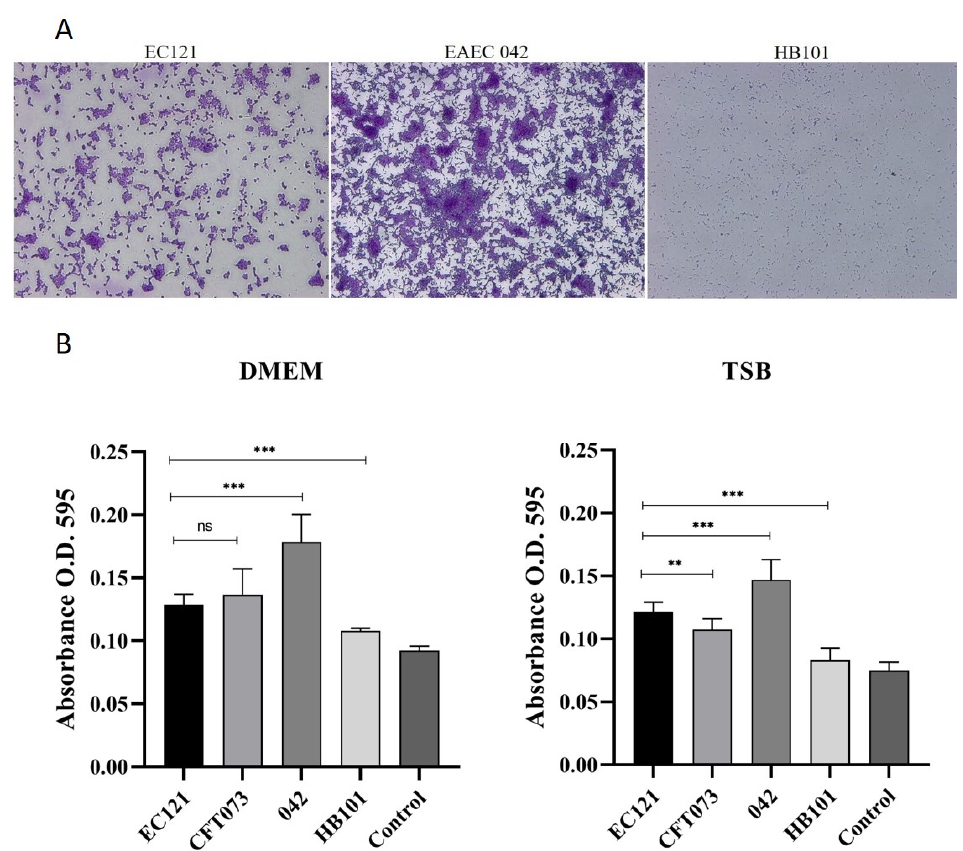
Figure 4. Biofilm formation on borosilicate glass and polystyrene abiotic surfaces. ( A ) Qualitative assay showing that EC121 strain adhered to glass coverslips after 24 h of incubation at 37 ◦ C, in DMEM. EAEC prototype strain 042 and E. coli HB101 were used as positive and negative controls, respectively. Bacteria were stained with crystal violet, observed by optical microscopy (OM) 400 × . ( B ) Quantitative biofilm assays were performed in Dulbecco (cid:48) s Modified Eagle (cid:48) s Medium (DMEM) and tryptic soy broth (TSB), at 37 ◦ C, for 24 h, comparing the capacity of strain EC121 to produce biofilm in polystyrene surface. EAEC 042 was used as a positive control, UPEC prototype strain CFT073 was used as an ExPEC control, and Laboratory strain HB101 was used as a negative control. p values: ** < 0.01; *** < 0.001; ns >